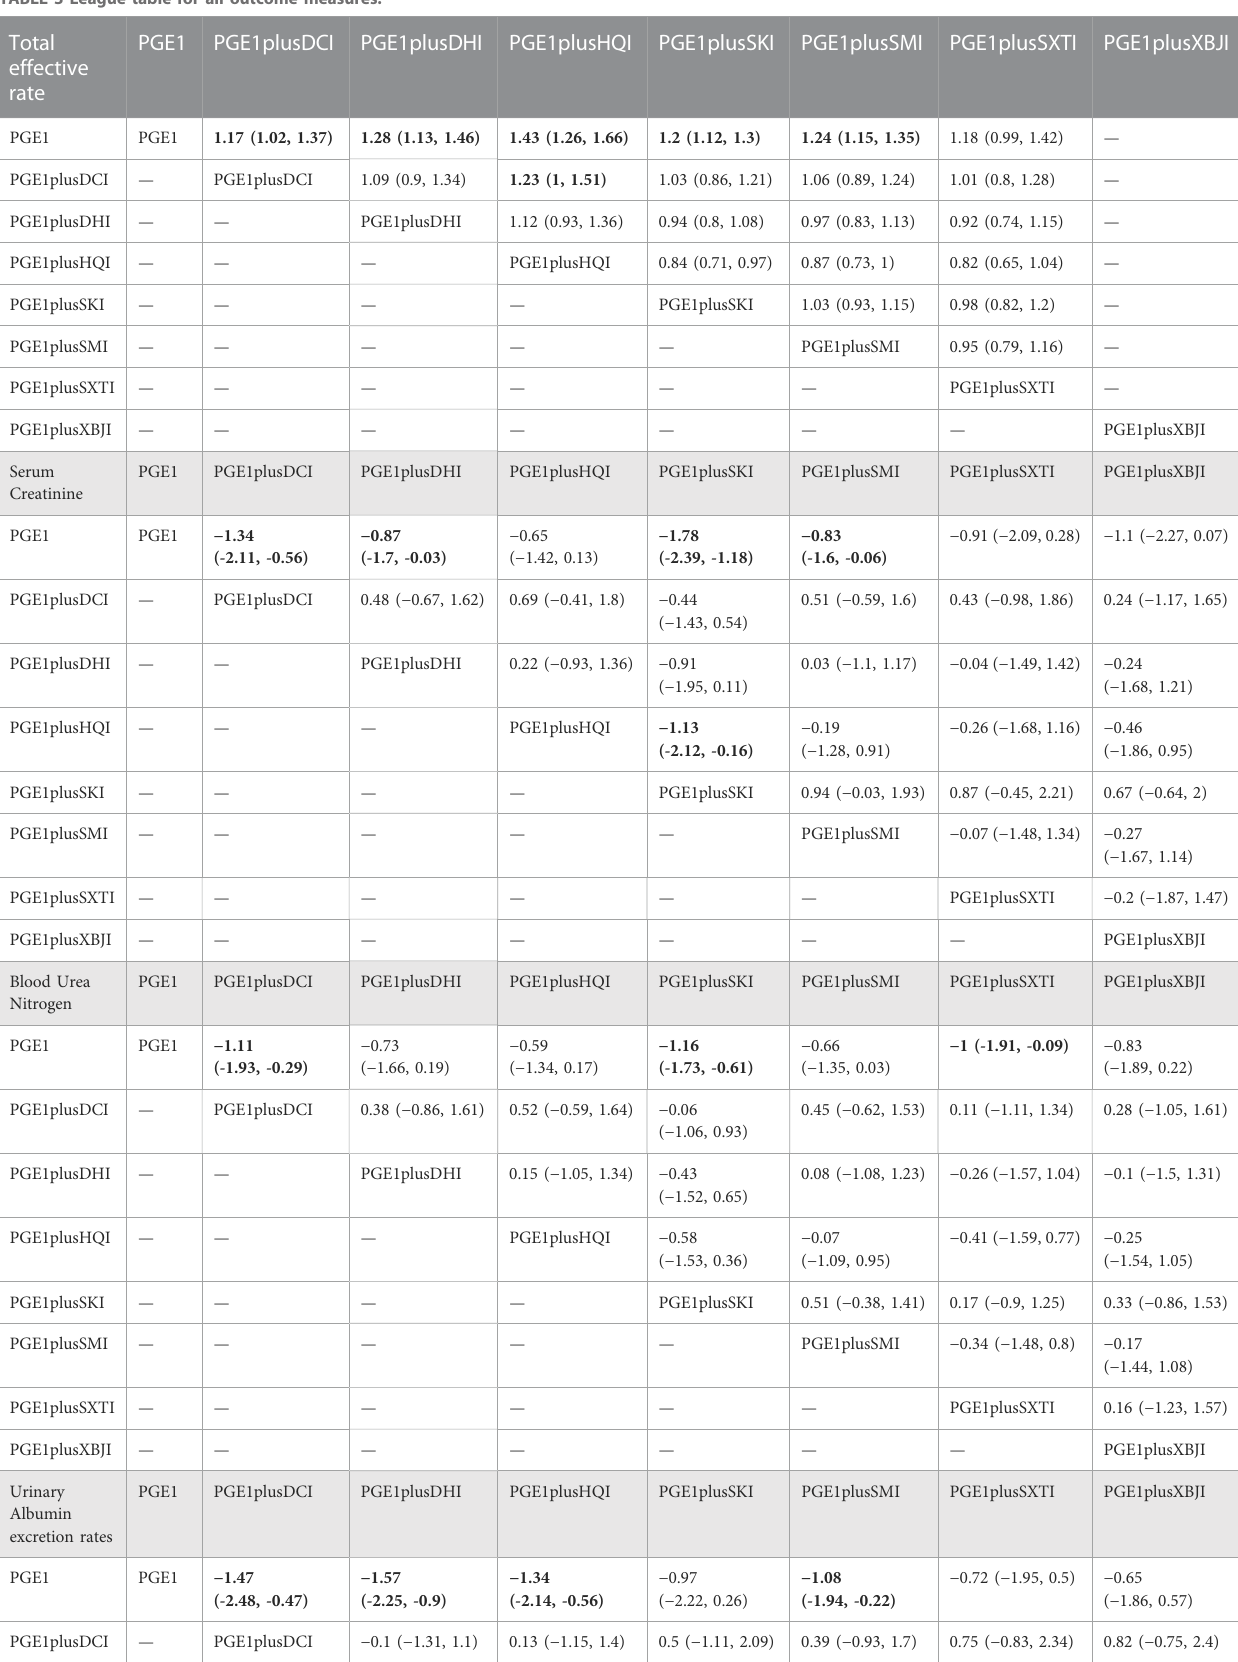
TABLE 3 League table for all outcome